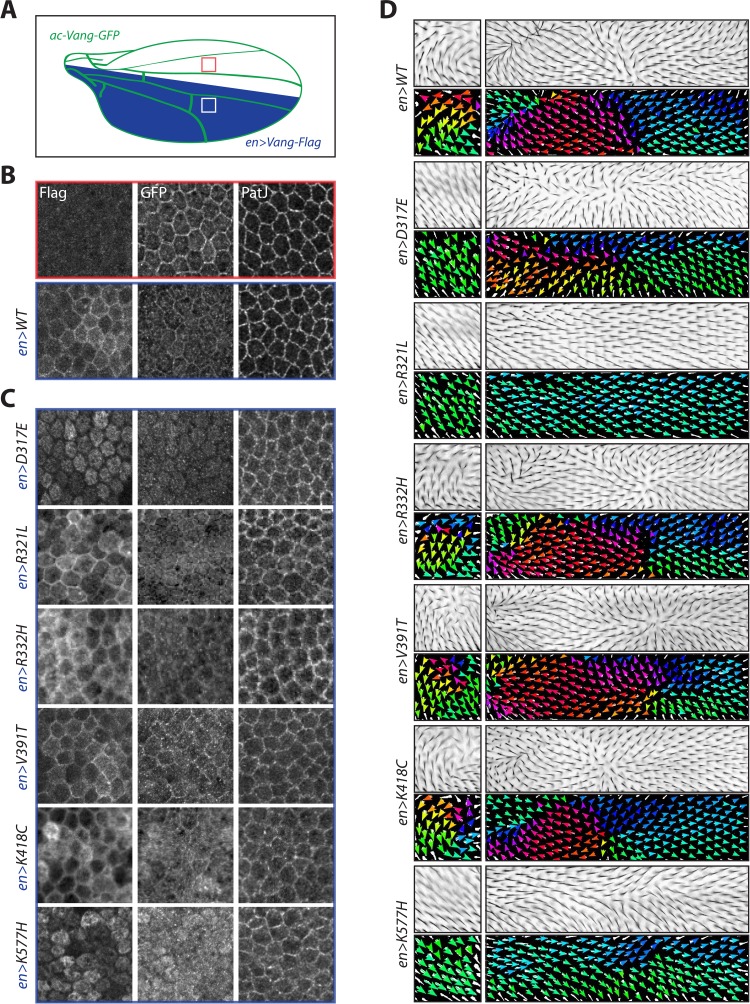
Overexpression of Vang transgenes affects localization of wild-type Vang.(A) Schematic showing regions of expression of different transgenes along the Drosophila wing blade. A direct actin-promoter driven (ac-Vang-GFP) construct is expressed at homeostatic levels throughout the wing blade, engrailed-Gal4 drives expression of wild-type Vang-Flag or each of the associated mutant proteins in the posterior compartment of the wing. (B) Representative immunofluorescence images of regions from the anterior and posterior regions of a pupal wing overexpressing wild-type Vang-Flag in the posterior region. Note recruitment of Vang-Flag to the membrane in the posterior region (blue), and concomitant reduction in membrane localization of Vang-GFP in the posterior (blue) vs. anterior (red) compartment. The junctional marker PatJ shows consistent membrane labeling in both regions. (C) Representative immunofluorescence images of regions from the posterior compartment of pupal wings overexpressing the indicated Vang-Flag constructs. Note differences in localization of Vang-Flag mutants as compared to wild-type Vang (B), as well as altered wt-Vang-GFP localization. The junctional marker PatJ was unaffected in each case. (D) Regions of adult wing showing hair reorientation phenotypes in the indicated genotypes. Note the similarity in pattern between overexpression of WT, R332H, V391T and K418C mutants (swirls, cf. GOF in Figure 2—figure supplement 1), as compared to R321L (wild-type orientation), and D317E and K577H (downwards reorientation, cf. LOF in Figure 2—figure supplement 1) in posterior region of the wing. Color range is same as in Figure 2.